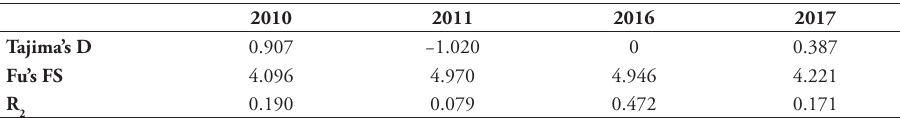
Table 7. Neutrality tests for mitochondrial sequences of Cadiz marina (ESCAD) population over time. Negative and significant values for Tajima’s D, Fu’s FS and Ramos-Onsis and Rozas’ R population expansion; * p < 0.05; ** p <